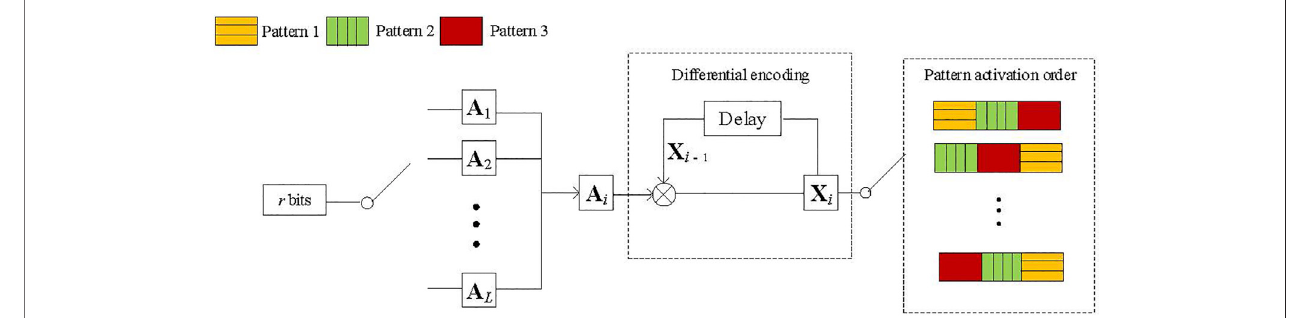
FIGURE 2 | Differential encoding process.